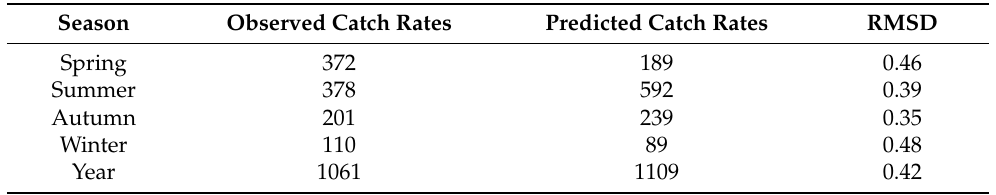
Table 4. The RMSD reflects the cumulative frequency data test error metric for the observed and predicted high catch rates (>60 percent) of greater amberjack in the TS in 2019. Season Observed Catch Rates Predicted Catch Rates RMSD Spring 372